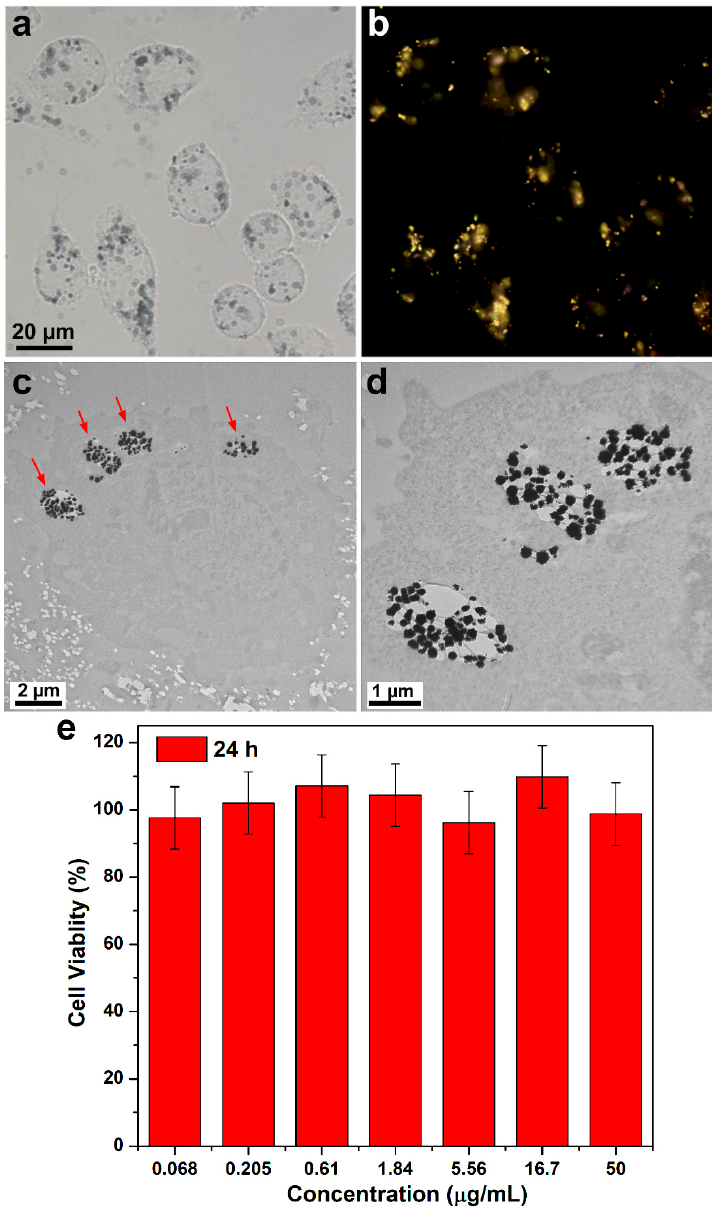
Figure 2. ( a ) Representative bright-field microscopy and ( b ) corresponding dark-field microscopy image of RAW macrophage cells treated with HAuNFs. Sectioned TEM images of a fixed Raw 264.7 cell treated with HAuNFs: ( c ) Low and high ( d ) magnification. The red arrows in ( c ) indicate HAuNFs; ( e ) cell viability of Raw 264.7 cells treated with varying concentrations of HAuNFs. Results are shown as mean ±SD ( n = 6) as determined using Cell Counting Kit-8 (CCK-8) assays.